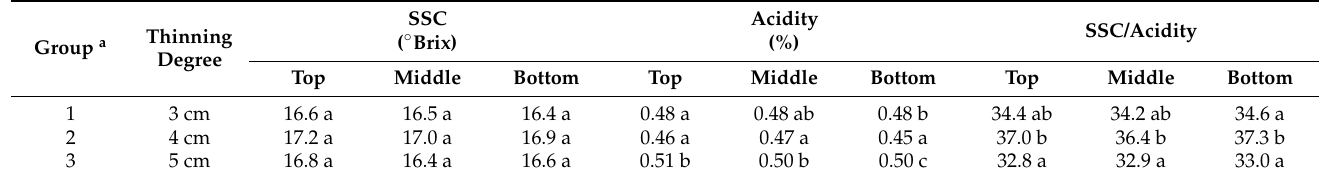
Figure 5. The shape of the ‘Shine Muscat’ grape berry at harvest according to different degree s of thinning to 3 cm, 4 cm, and 5 cm. Thinning was performed seven days before the full bloom. Table 6. Comparison of soluble solid content (SSC) among the fruits from different lengths of floral cluster thinning by hand.